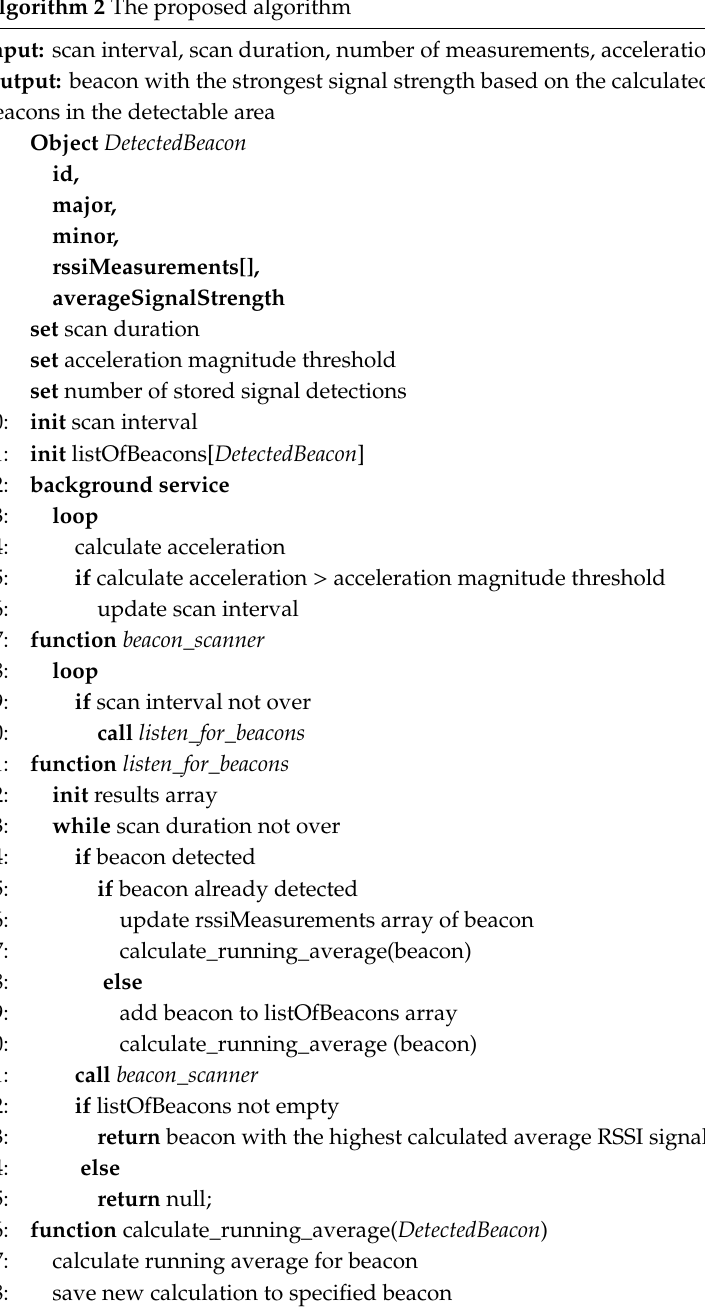
Algorithm 2 The proposed